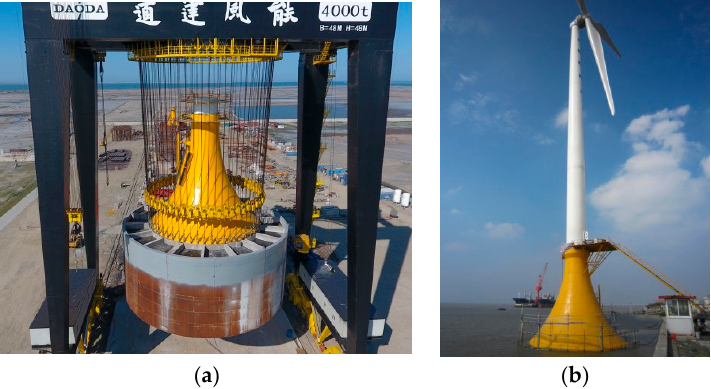
Figure 1. Pictures of the composite bucket foundation in China: ( a ) Transition section; ( b ) Offshore wind turbine with CBF.